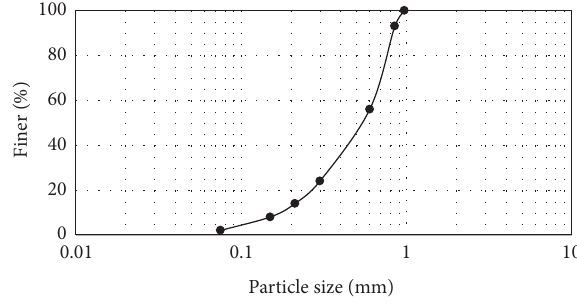
Figure 2: Gradation curve of the Johor Bahru sand.